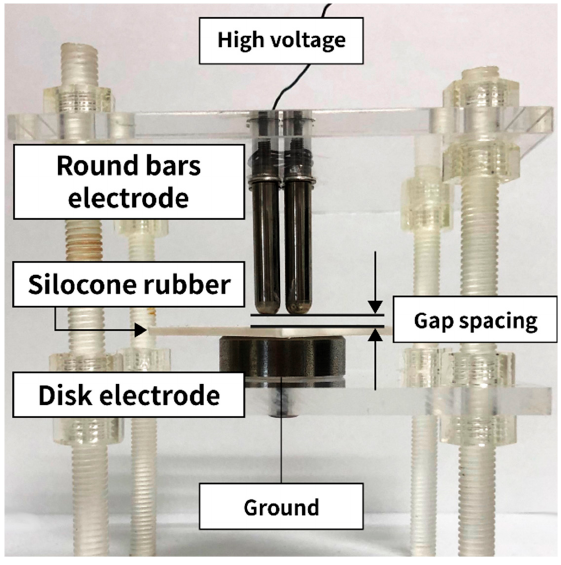
Figure 1. Electrode system.